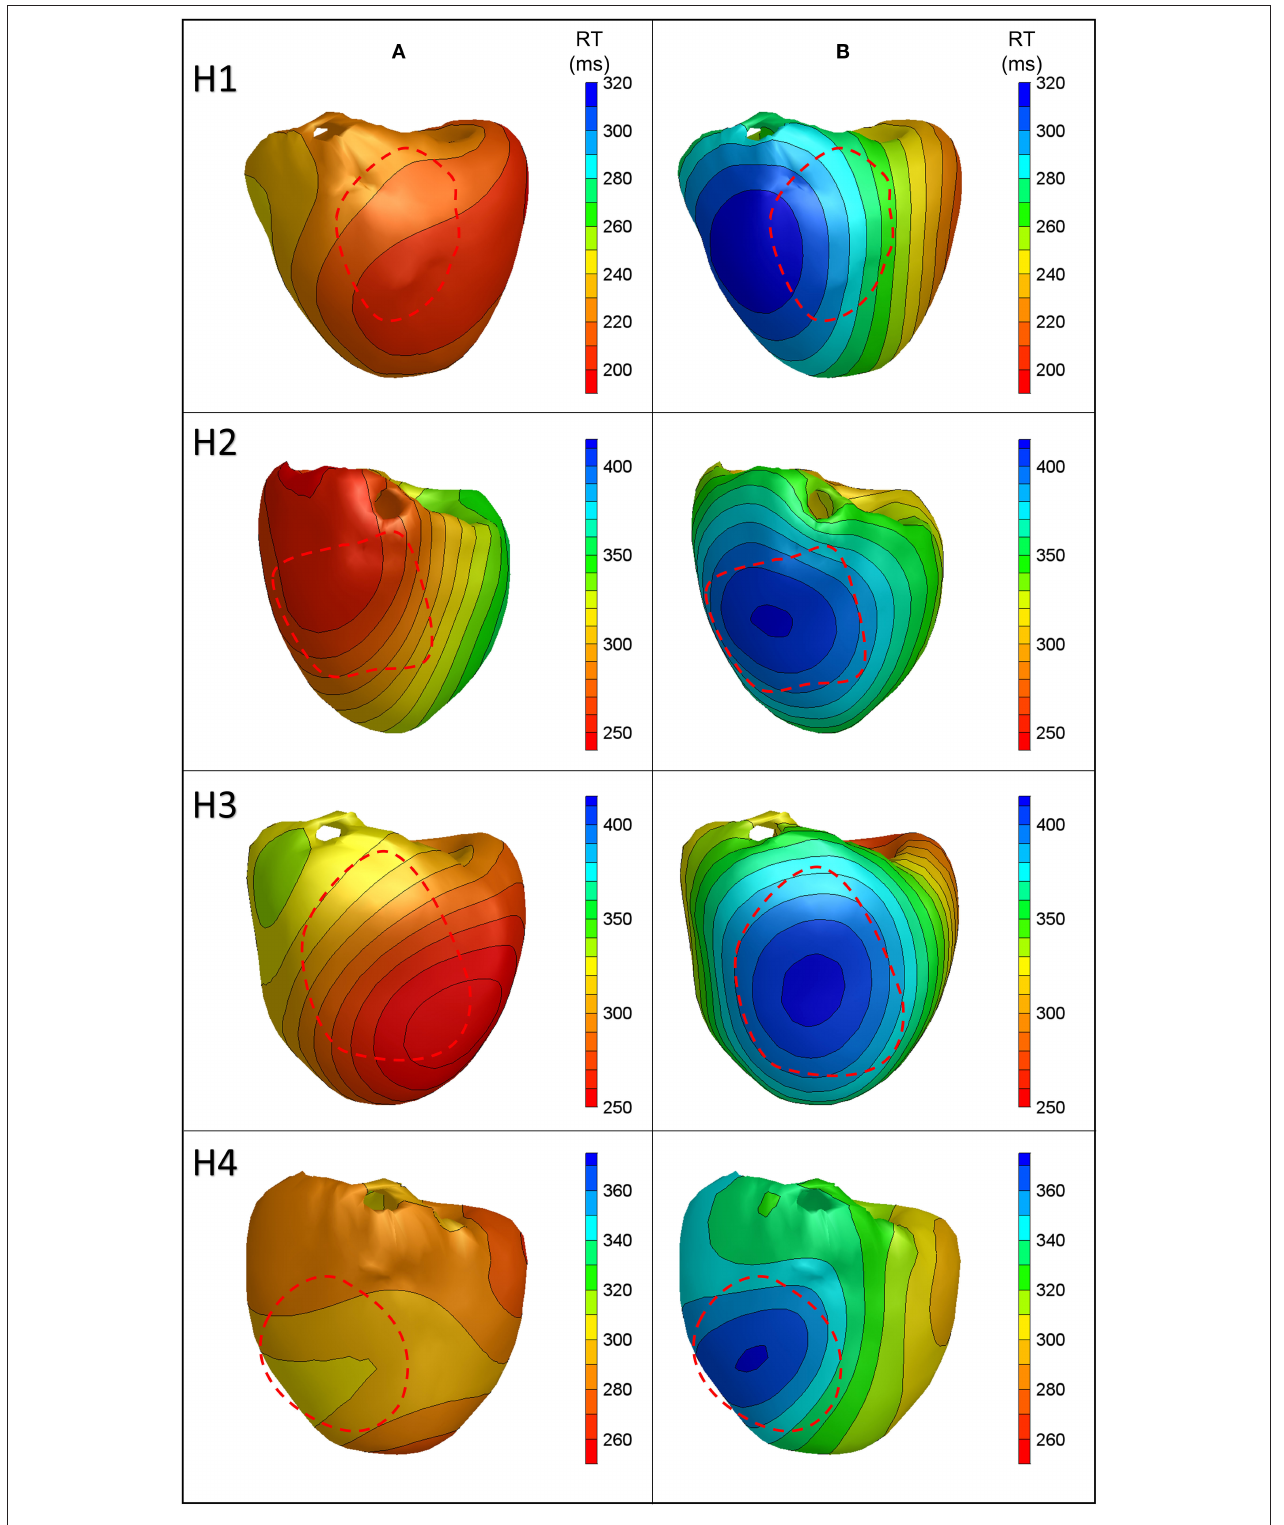
FIGURE 4 | Anterior views of reconstructed repolarization times for atrially paced beats in all hearts with (B) and without (A) cold perfusion of the left anterior descending artery (LAD) region. The red dashed line indicates the estimated LAD perfusion area.